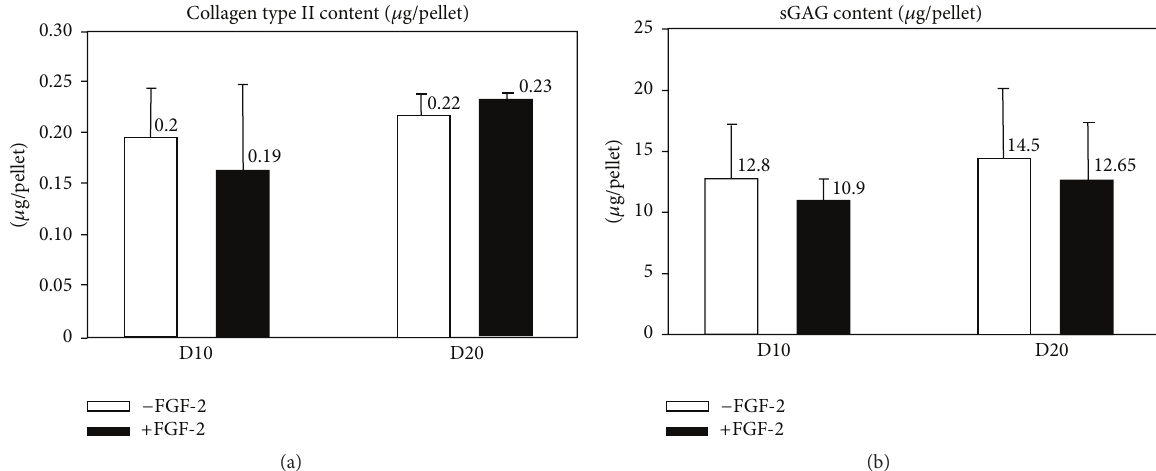
Figure 7: Collagen type II (a) and sGAG (b) proteins content ( 𝜇 g/pellet) on days 10 and 20 of chondrogenic culture with (white) or without (black) FGF-2 supplementation ( 𝑛 = 5 ).